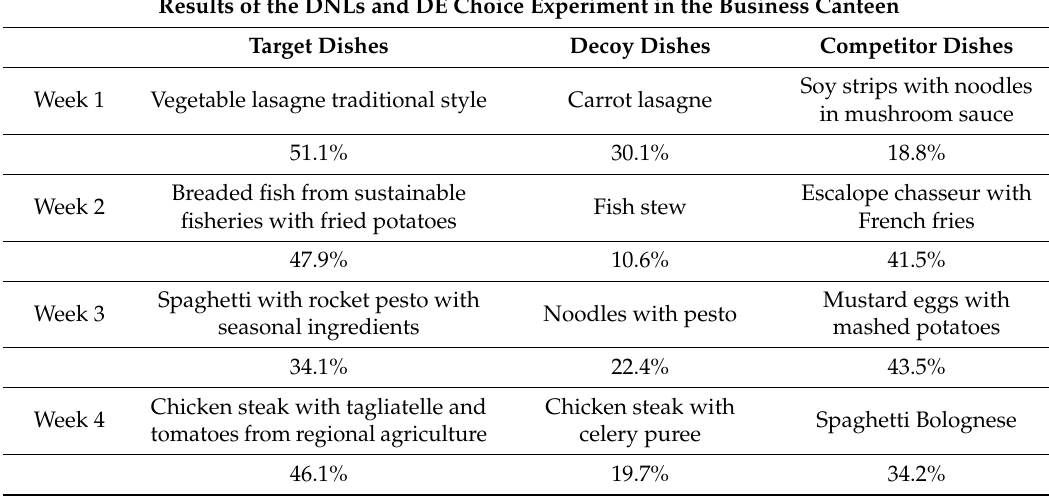
Table 9. Results of the DNLs and DE choice experiment in the business canteen.